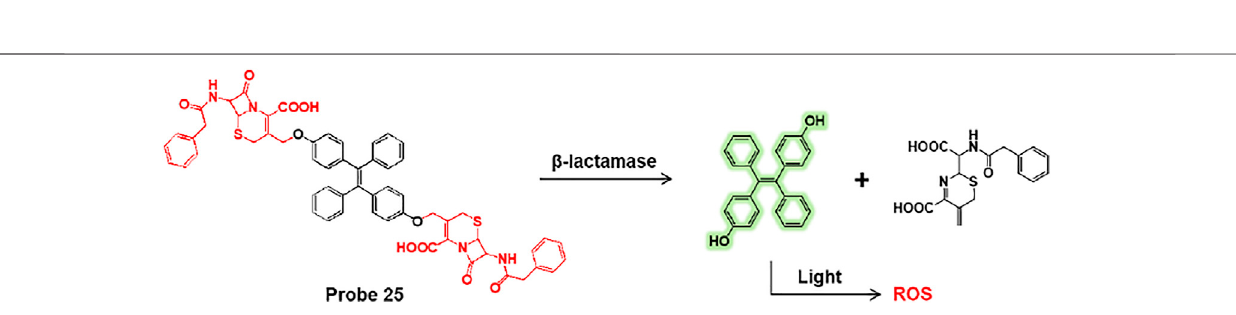
FIGURE 13 | Cleavage reaction of probe 25 by β